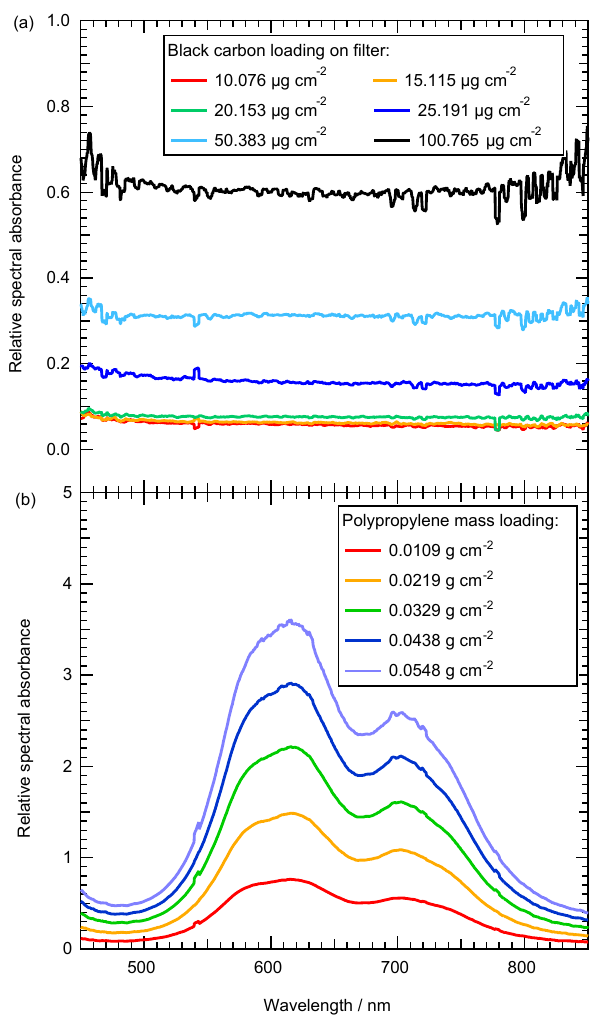
Figure 4. (a) Relative spectral absorbance of black carbon ver- sus wavelength for various loadings of black carbon on the filter. (b) Relative spectral absorbance versus wavelength for different mass loadings of